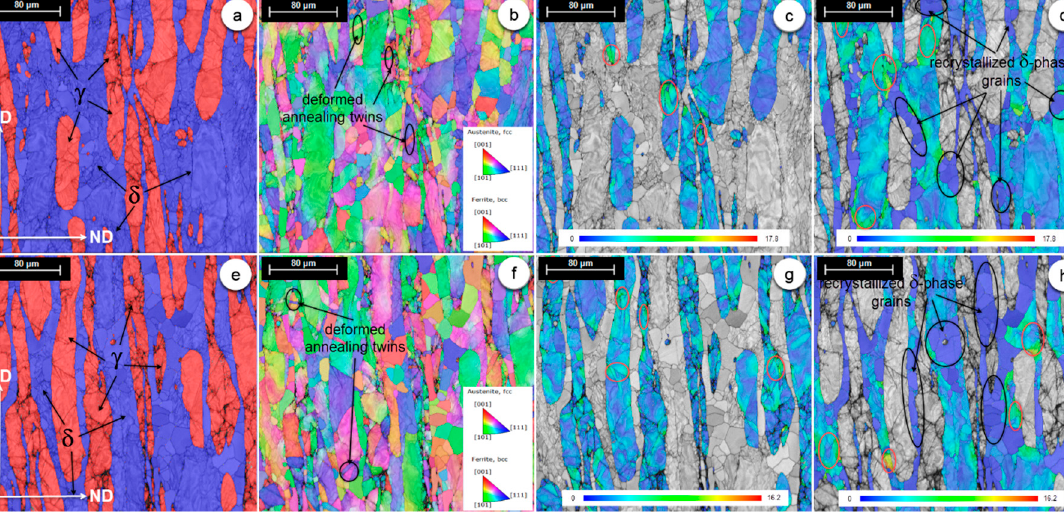
Figure 6. Distribution maps of both the γ - and δ -phases ( a ), inverse pole figure (IPF) ( b ), GROD map of the γ -phase ( c ) and δ -phase ( d ) for the short-duration aging treatment ( A2.1 ) state; distribution maps of both the γ - and δ -phases ( e ), inverse pole figure (IPF) ( f ), GROD map of the γ -phase ( g ) and δ -phase ( h ) for the long-duration aging treatment ( A2.2 ) state.